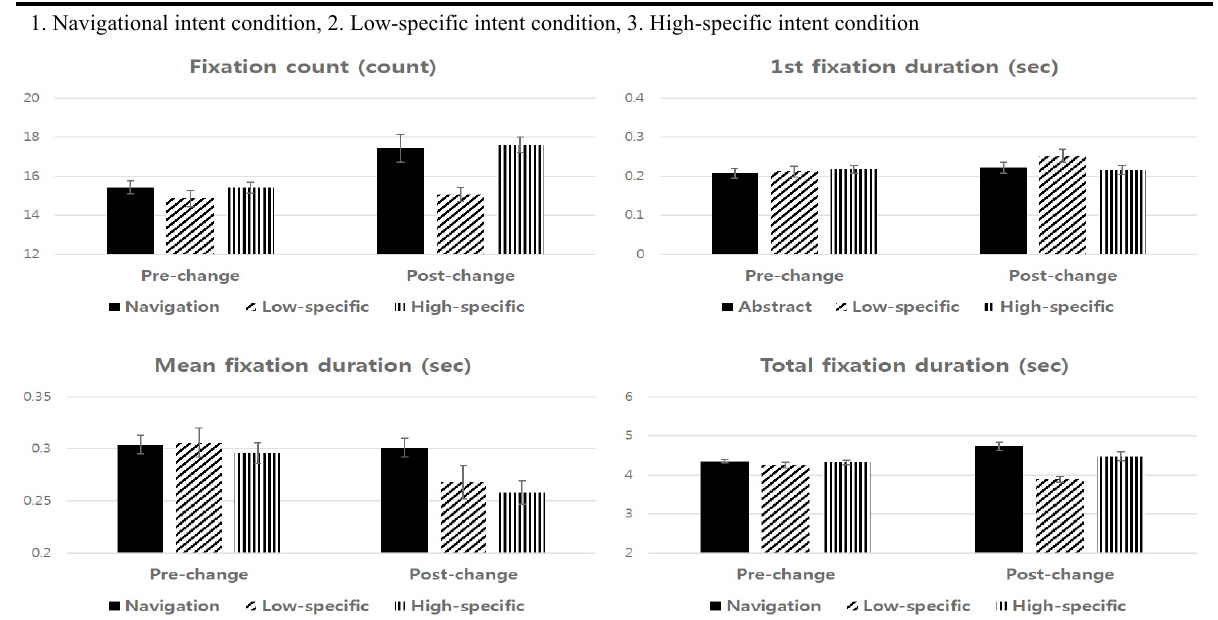
Figure 3. Mean differences between DVs for each intent condition, across scene conditions (pre- and